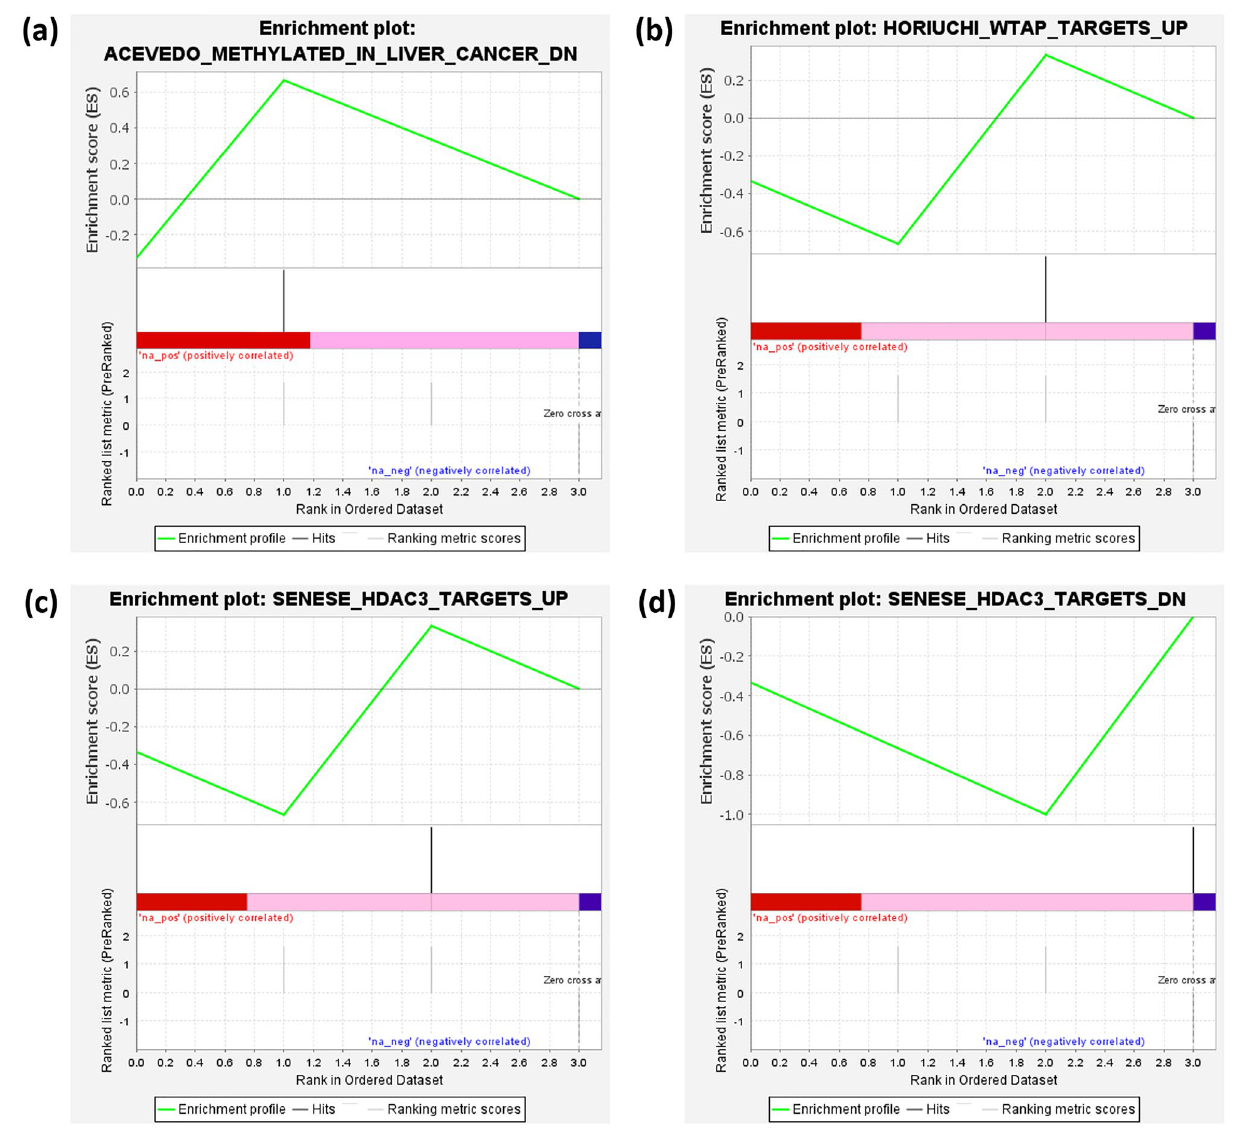
Figure 9. Gene set enrichment analysis (GSEA) exhibiting the biological process associated with the ( a ) F11-AS1, ( b ) CACNA1G-AS1, ( c ) NNT-AS1, and ( d ) MSC-AS1. A positive enrichment score represents positive correlation with the phenotype profile where a negative score represents inverse correlation with the phenotype profile. Red, pink and blue color indicate the high, moderately high, and low